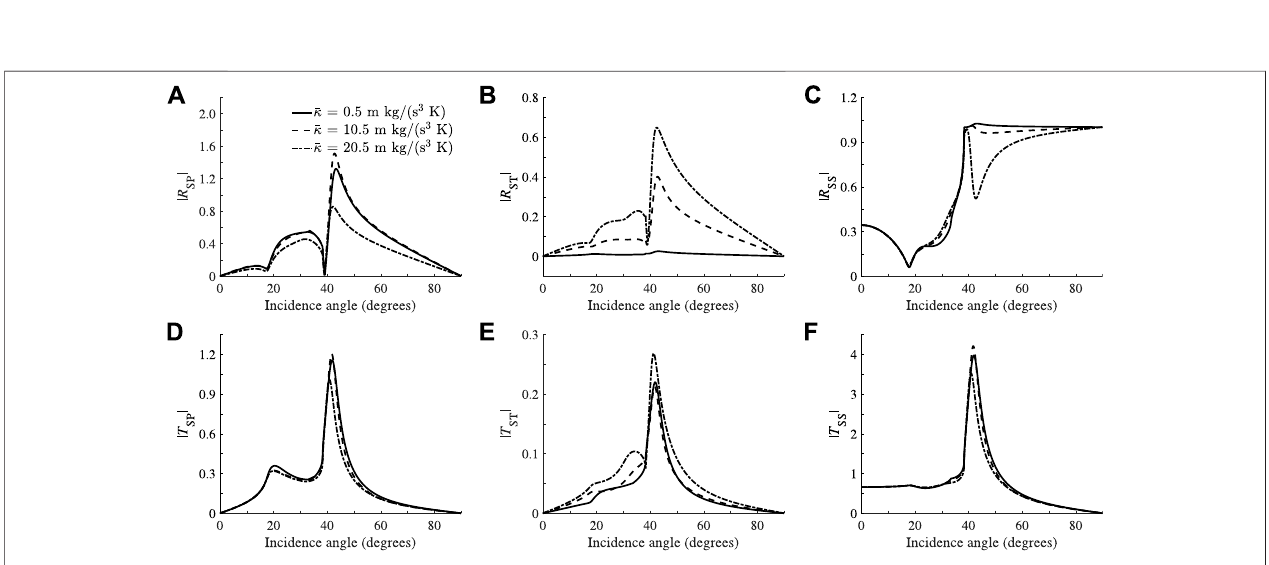
FIGURE 14 | Same as Figure 12 but for the absolute values of the re fl ected P (A) , re fl ected T (B) , re fl ected S (C) , transmitted P (D) , transmitted T (E) and transmitted S (F) waves as a function of the S-wave incidence angle.